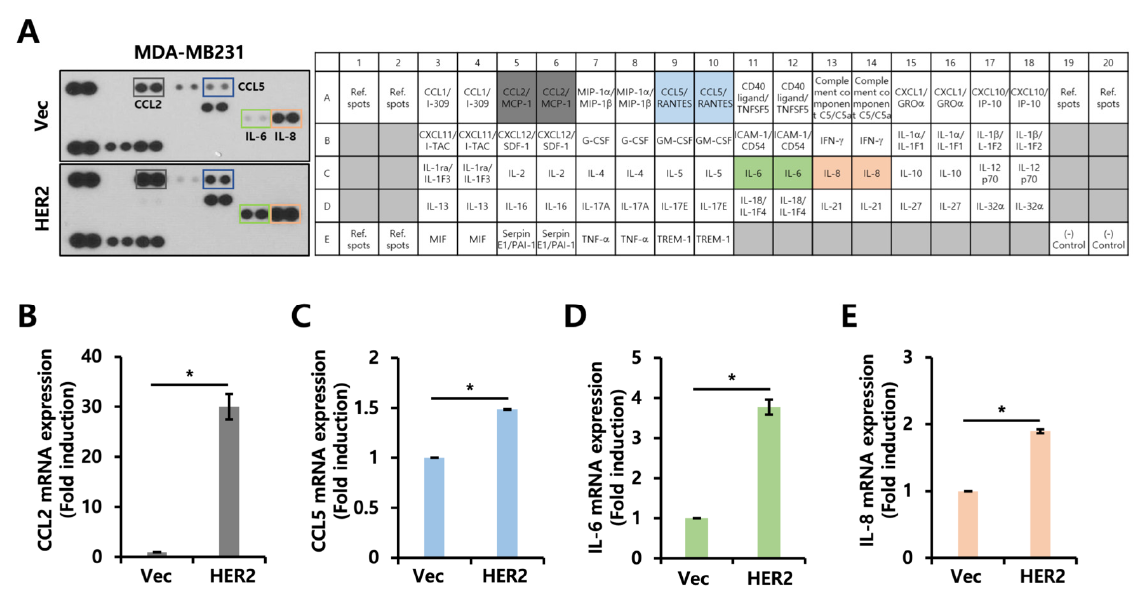
Figure 3. Cytokine secretion profile is altered by HER2 overexpression. ( A ) Human cytokine array was performed using conditioned culture media of MDA-MB231 Vec and HER2-overexpressed cells. ( B – E ) Transcript levels of CCL2 , CCL5 , IL-6 , and IL-8 in Vec and HER2-overexpressed MDA-MB231 cells were analyzed using RT-qPCR. Values were normalized to ACTB . * p < 0.05.